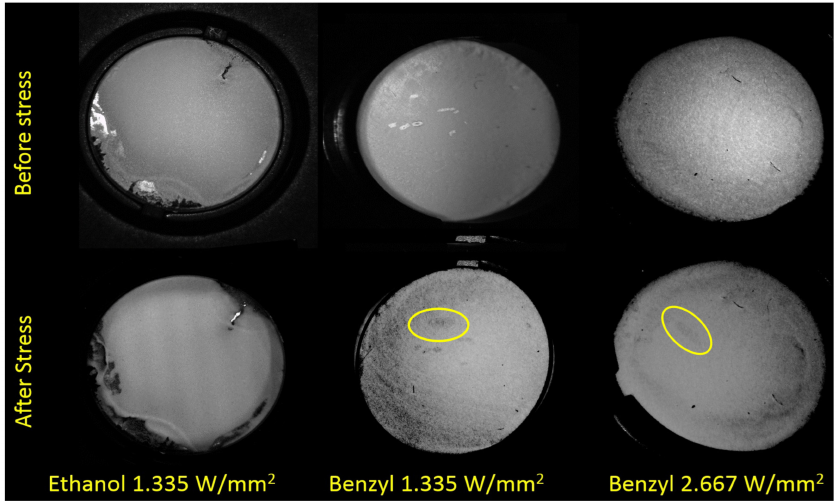
Figure 3. High contrast photoluminescence images of the phosphor templates deposited by means of benzyl and ethanol solvents, before and after the ageing treatment.